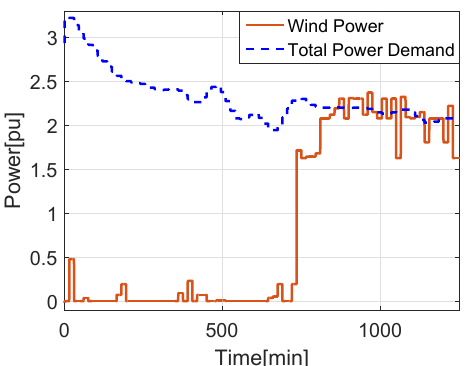
Figure 1. Power delivered by the wind turbine (red), and total power demand of the industrial process (blue) used in the simulations. After 900 min, the non-conventional energy sources (NCES) provides enough power to satisfy the